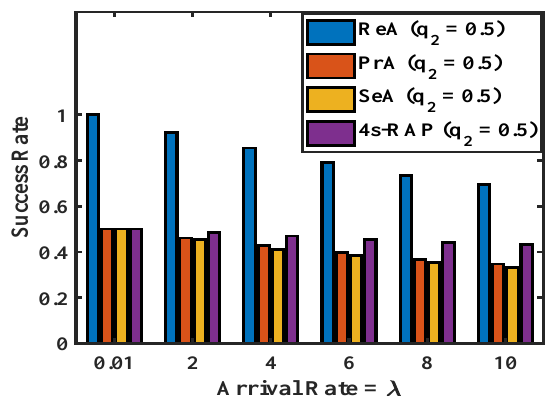
Figure 5. Success rate ( q 2 = 0.5) .